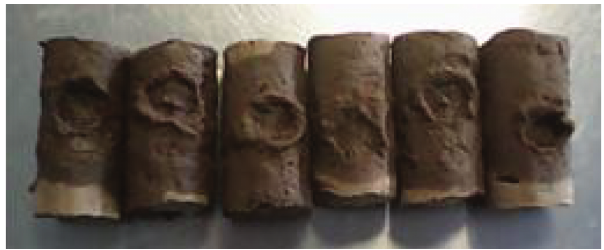
Figure 6: Drip test specimen showing depth of